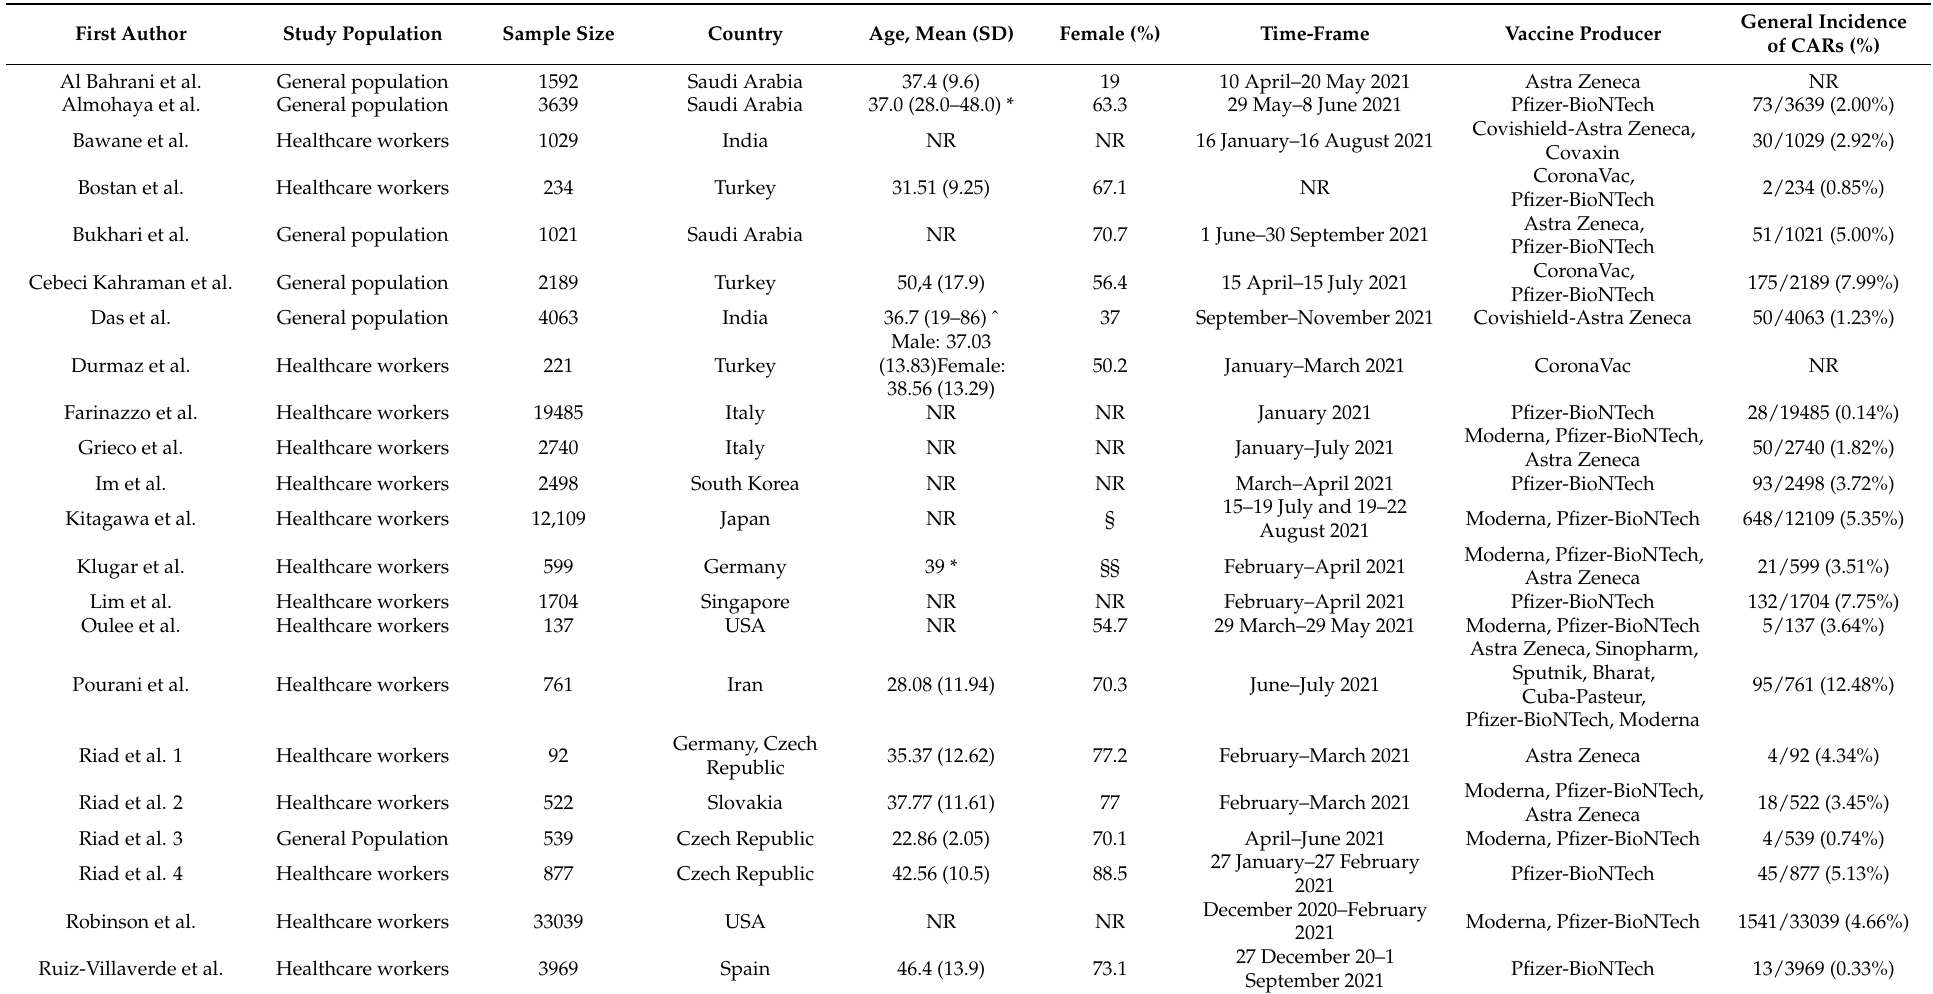
Table 1. Characteristics of the studies included in the